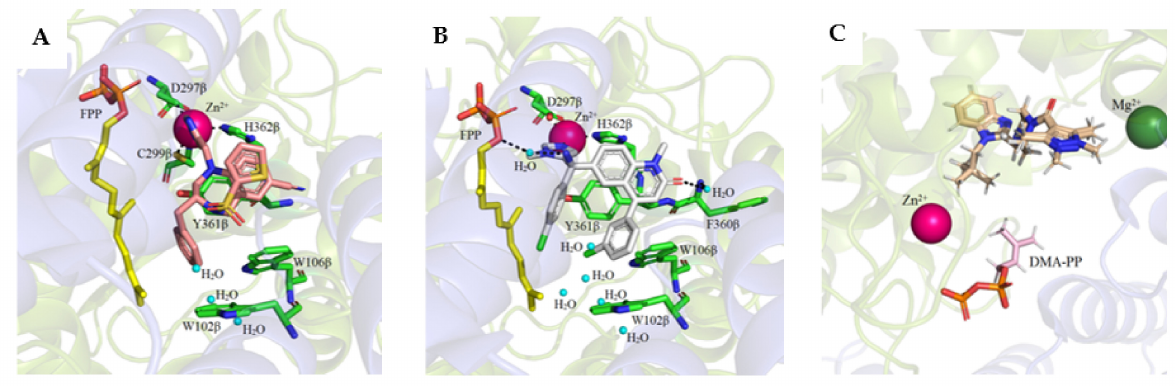
Figure 9. Structures of farnesyltransferase complexed with FPP and BMS-214662 ( A ) (PDB: 1SA5), with FPP and R115777 ( B ) (PDB: 1SA4), and with compound 1 [53] ( C ) (PDB: 7RNI). (Created in the PyMOL Molecular Graphics System, Version 2.5.2 Schrödinger, LLC).